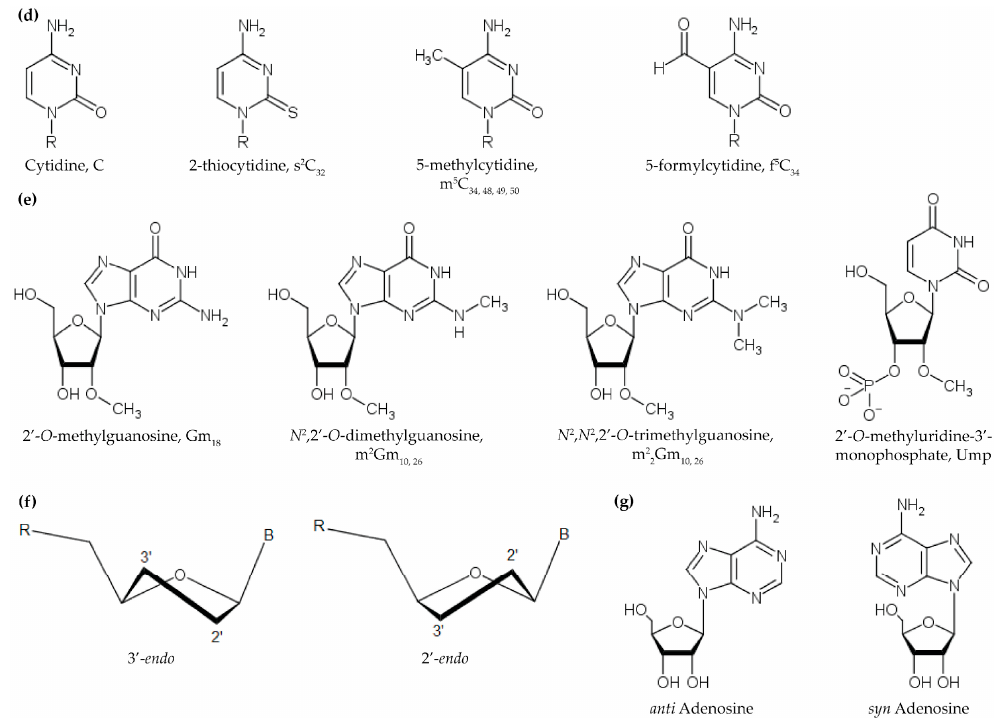
Figure 2. Nucleoside Modifications and Conformations. Some 90 modified nucleosides appear in tRNAs. The modifications, nucleobase and ribose conformations addressed in this review are ( a ) Adenosine and its modifications (R = ribose); ( b ) Uridine and its modifications (R = ribose); ( c ) Guanosine and its modifications (R = ribose); ( d ) Cytidine and its modifications (R = ribose); ( e ) 2’ ‐ O ‐ methylated nucleosides; ( f ) C3’ ‐ endo versus C2’ ‐ endo (R = OH or phosphate; B = nucleobase); ( g ) anti adenosine versus syn adenosine.